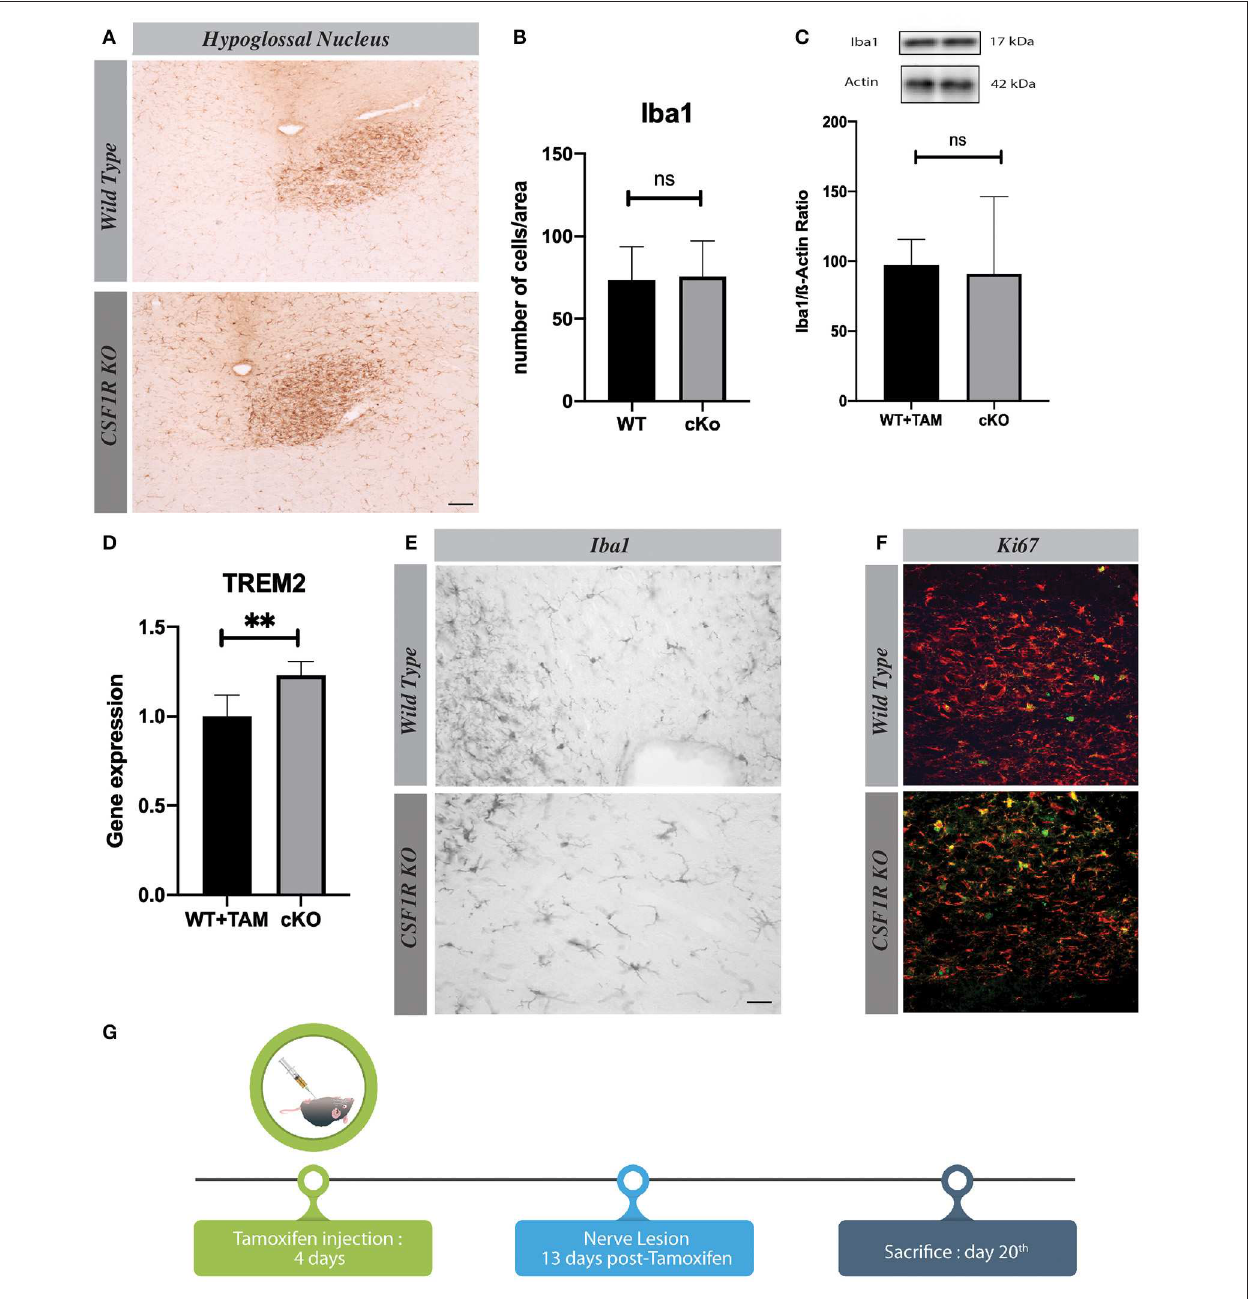
FIGURE 3 | Knocking-out CSF1R selectively in microglia does not impair microglial cell proliferation. (A) Representative images of Iba1 staining in hypoglossal nucleus, using different timelines, and (B) their quantification presented as percentage of area occupied by Iba1 staining measured in hypoglossal nucleus. (C) Level of Iba1 in cerebellum by Western blot. (D) Quantification of TREM2 gene expression in cerebellum by RT-Q-PCR. (E) Representative images of microglial morphology in cKO and WT mice. (F) Representative images of Iba1 (red) and Ki67 (green) staining in hypoglossal nucleus area. (G) Time course used for analyses. Values are expressed as means ± SEM. Statistical analyses were performed using t -test, p < 0.005. Scale bar 100 µ m. n = 3–5 mice. ** p < 0.01.